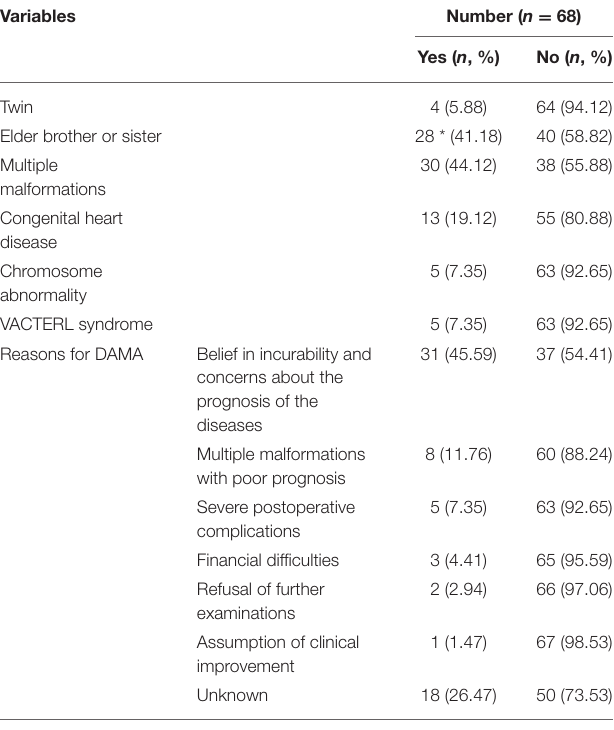
TABLE 4 | The clinical characteristics of the DAMA